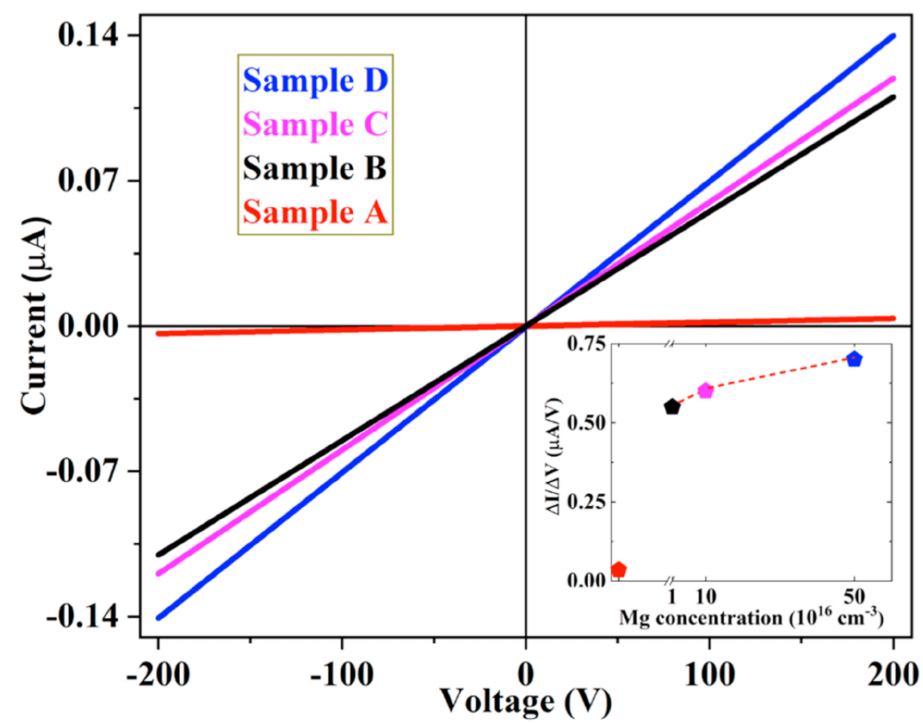
Figure 4. Current versus voltage measurements recorded in the undoped and Mg-doped h-BN A-D samples. The inset shows the variation of the slope of the different curves with the Mg